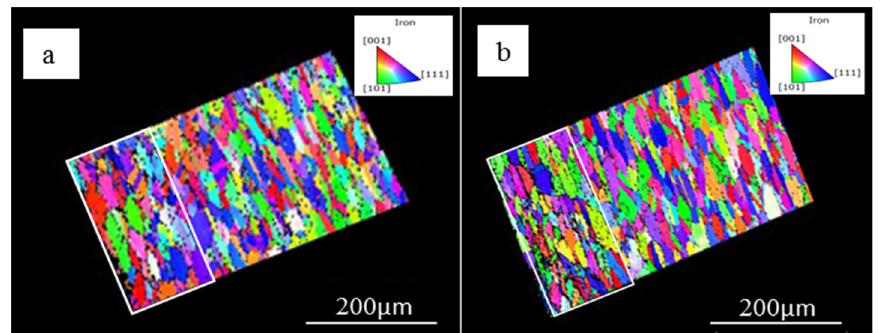
Figure 2. EBSD diagram of the cross section of a 316L stainless steel sample before and after laser shock treatment: ( a ) untreated and ( b ) after one laser shock peening treatment.